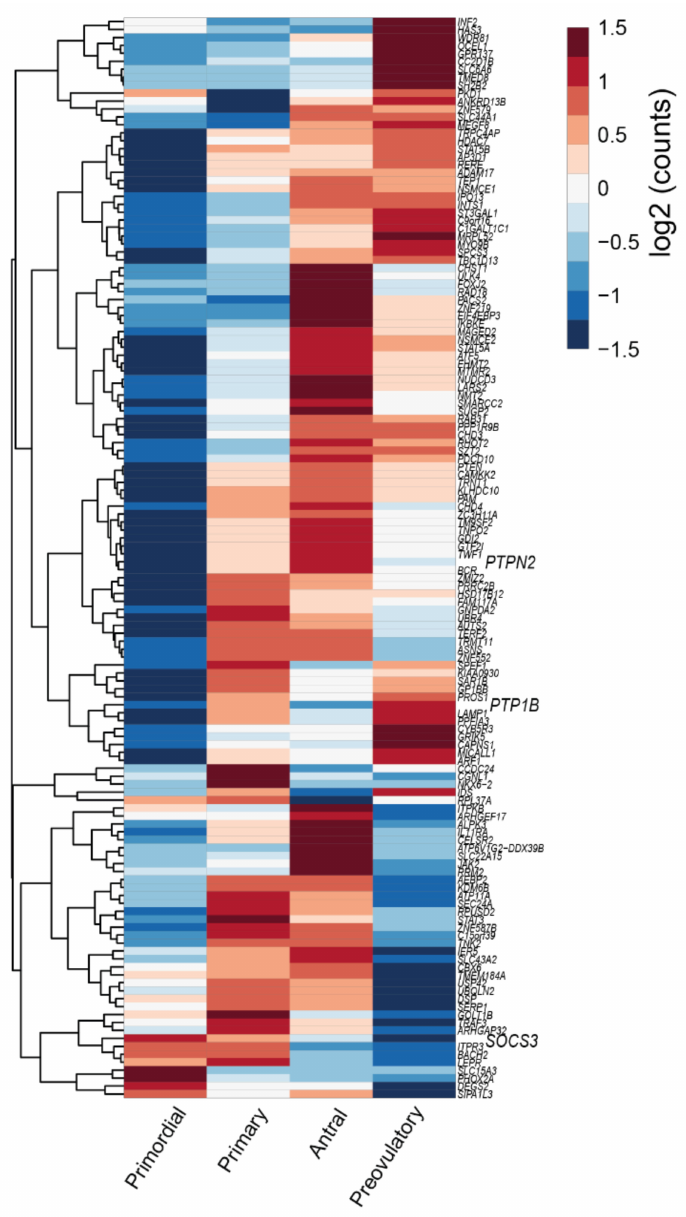
Figure 5. Heatmap representing transcription profile of genes identified as differentially expressed in cumulus cells of mice both fed high fat diet for 4 wk and treated with leptin (for details please see [6]) in human granulosa cells throughout folliculogenesis. Primordial = primordial follicle; Primary = primary follicle; Antral = antral follicle; Preovulatory = preovulatory follicle. Color code from blue to red indicates the relative gene expression level from low to high, respectively. Data from Zhang et al. 2018 [30]; 134 DEGs plus 10 leptin pathway genes—Table S2. Suppressor of cytokine signaling (SOCS) 3, protein tyrosine phosphatase non-receptor type 2 ( PTPN2 ), protein tyrosine phosphatase ( PTP )